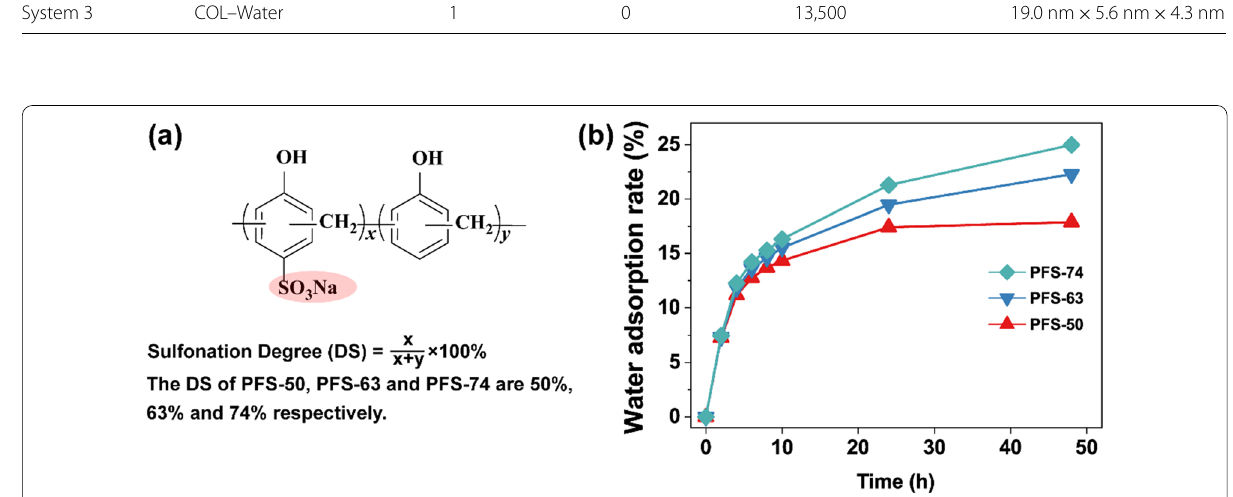
Fig. 2 a Schematic diagram and b water absorption curves of PFSs with different sulfonation